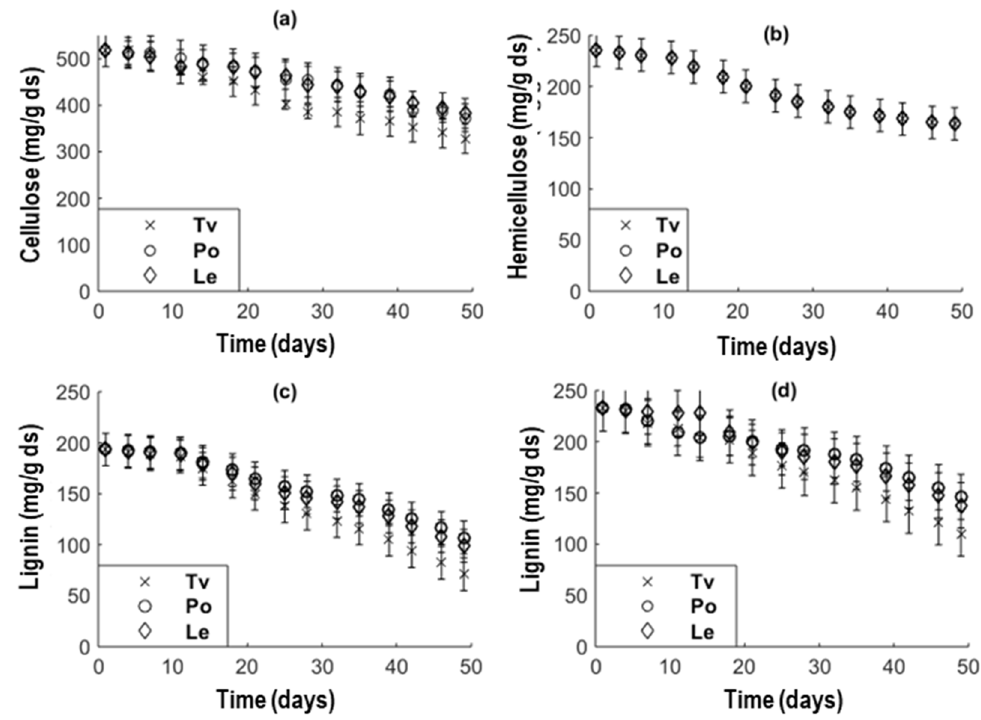
Figure 3. Consumption and degradation of the main components of the lignocellulosic substrates by T. versicolor (Tv), P. ostreatus (Po), and L. edodes (Le) grown on di ff erent solid media based on oak sawdust, coconut fiber, co ff ee husks, corn bran, and soybean oil during 49 cultivation days under solid-state fermentation conditions. ( a ) Cellulose consumption for F11 medium. ( b ) Hemicellulose consumption for F4 medium. ( c ) Lignin degradation for F1 medium. ( d ) Lignin degradation for F12 medium. The formulation for each medium is deciphered in Table 1; ds: dry